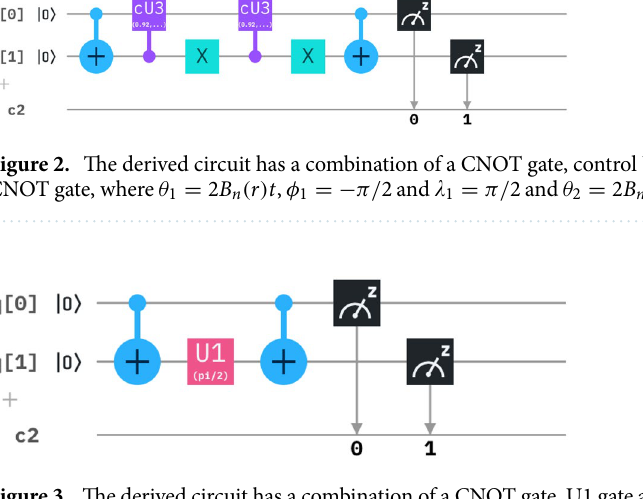
Figure 3. The derived circuit has a combination of a CNOT gate, U1 gate and a CNOT gate, where θ = 2 C n ( r ) t .